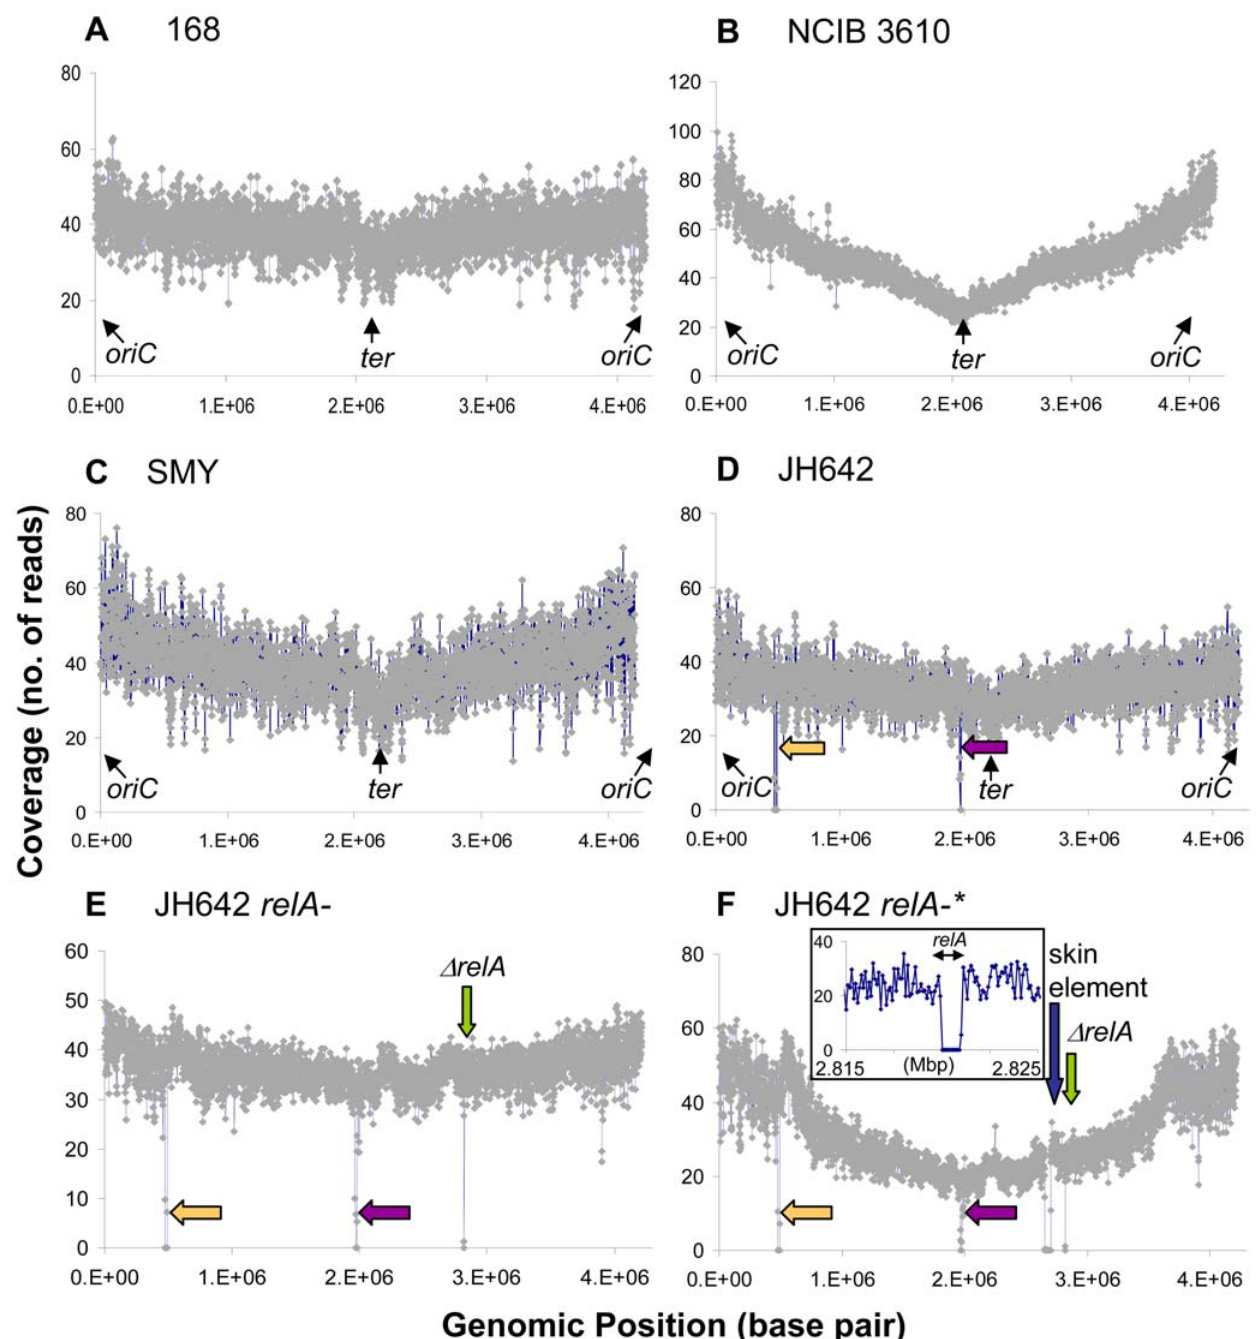
Figure 1. B.subtilis strains sequenced and the number of Solexa sequencing reads at each genomic position for each strain. A) B. subtilis 168 (BGSC 1A700); B) NCIB 3610 (BGSC 3A1); C) SMY (BGSC 1A775); D) JH642 (BGSC 1A96); E) JH642 with relA deletion; F) JH642 with relA deletion and second site suppressors ( relA -*). Yellow arrows: 18 kb deletion ( ydzA - ydbA ) in JH642; purple arrows: 9 kb deletion ( ppsC - ppsD ) in JH642; green arrows: 2 kb relA deletion in strains relA - and relA -*; blue arrow: skin element deletion in relA -*. Coverage was obtained by calculating the average number of reads in each 1 kb window. Inset in Figure 1F) is the high resolution coverage map (average reads per 0.2 kb window) of the relA region. The origin of replication is at the 0/4.2 Mbp genomic position, and the terminus of replication is at the 2.1 Mbp genomic position. NCIB 3610 and relA -* were grown to mid log phase, while the other strains were grown to stationary phase. The different shapes of the coverage maps might be partly due to these differences in growth phases. consensus sequence to the BAC reference sequence, we found that the error rate was around 0.01% at a quality score of 40, meaning re-sequenced using the Genome Analyzer. By comparing the that the accuracy of each base call was around 99.99% (data not